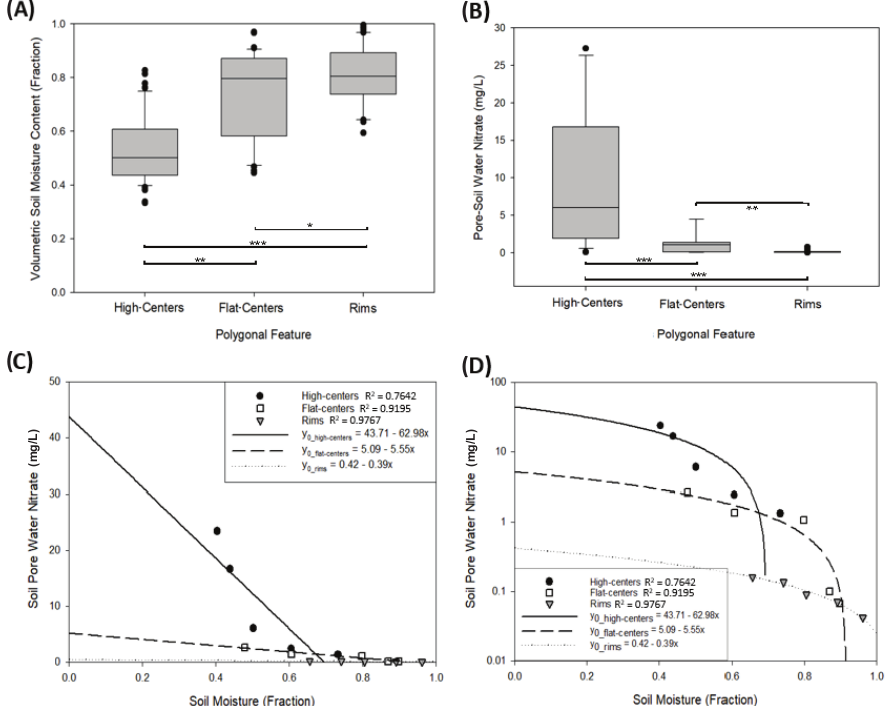
Figure 3. Ranges of moisture content ( A ) and NO 3 − concentration ( B ) distributed by unsaturated polygonal microtopographic features (high-centers, flat-centers, rims). The data used for the ranges displayed in ( A , B ) were not co-located but were distributions from each unsaturated feature for all NO 3 − and moisture data collected. The whisker extent and lines within the grey boxes indicate the 90%, 75%, 50%, 25%, and 10% statistical quantile distributions (see Table A1 for additional details), and statistical outliers are indicated by black circles. All p-values for pairwise comparisons between polygon features for ( A , B ) are <0.05, and asterisks displayed denote the level of significance for each comparison (*** indicates P ≤ 0.001; ** indicates P ≤ 0.01; * indicates P ≤ 0.05). ( C , D ) both show identical data and regressions with ( C ) displaying a linear y-axis scale, and ( D ) displaying a loga- rithmic y-axis scale for multiple visual perspectives. Both ( C , D ) show plots of the inverse statistical quantile distribution (see Table A1 for additional details) regressions of NO 3 − concentrations and soil moisture content for high-centers (black circles), flat-centers (open-squares), rims (grey triangles), and the linear regression equations for high-centers (solid line), flat-centers (dashed line), and rims (dotted line). Regression coefficients of determination are provided in the